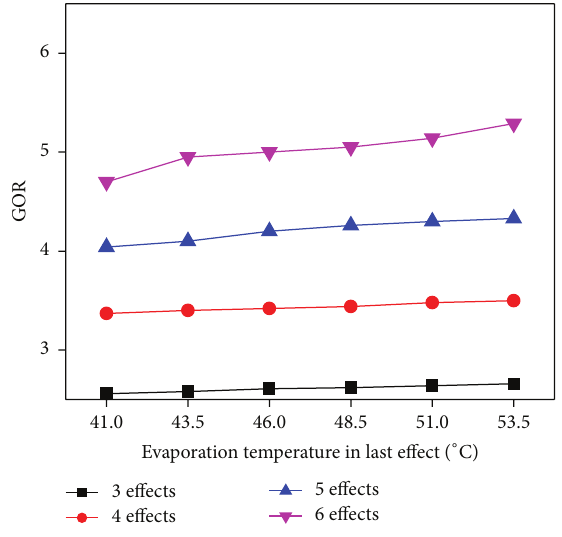
Figure 3: Variation of GOR with evaporation temperature in last effect.